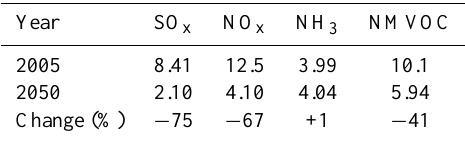
Table 2. Emissions for EU28 + used in the calculations for 2005 and 2050. Data from the IIASA/ECLIPSE v.4 e data set; see text. Unit: Tgyr − 1 (SO x as SO 2 , NO x as NO 2